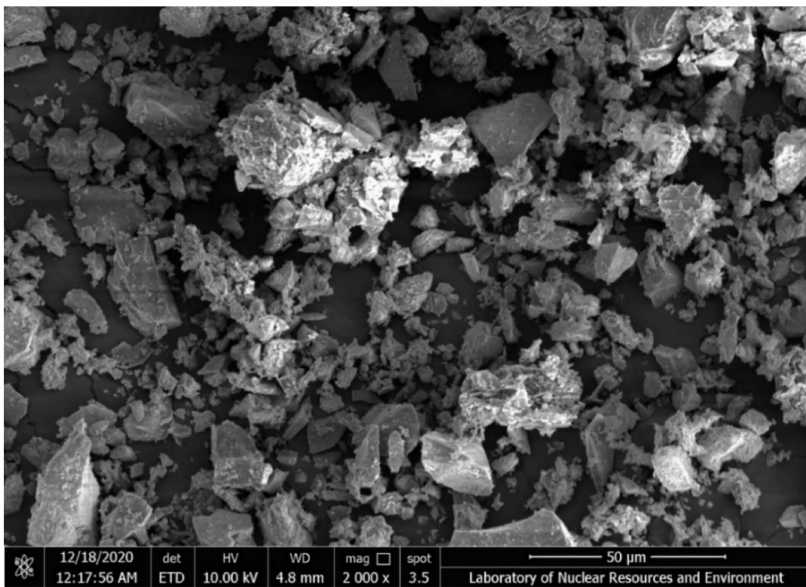
Figure 1. SEM image of tantalum-niobium slag.